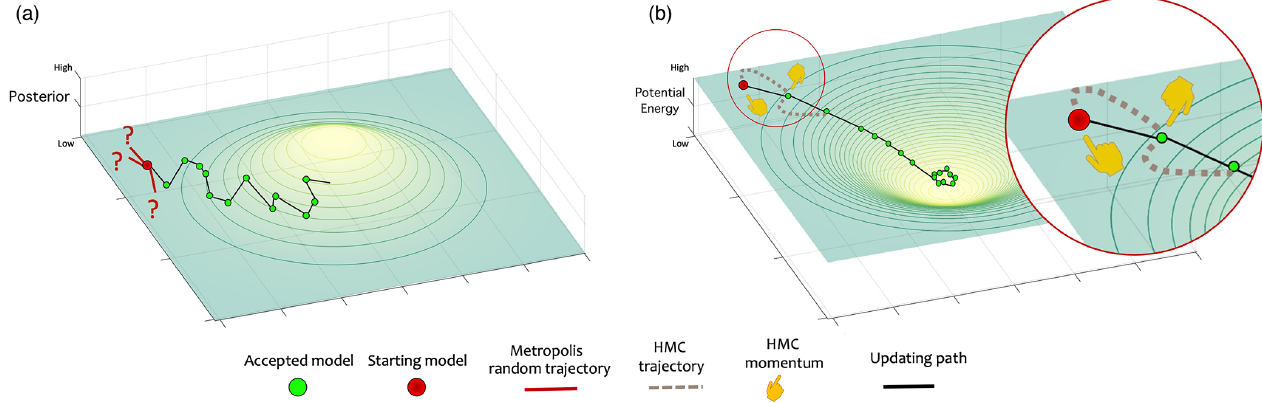
Figure 1. Comparison between the sampling strategy of the (a) Metropolis algorithm and (b) Hamiltonian Monte Carlo